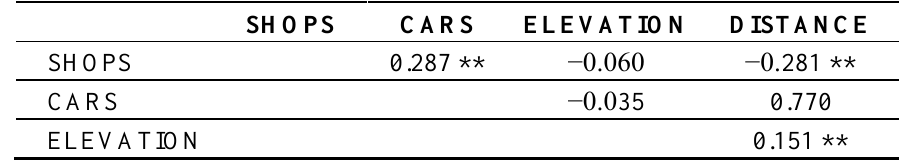
Table 3. Correlation between predictor variables.